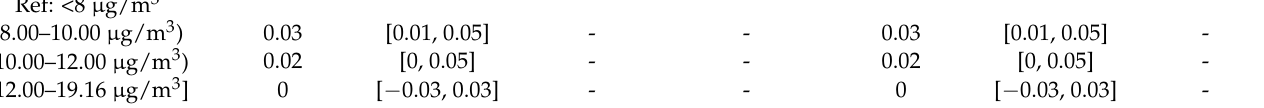
Panel B: Direct and indirect associations of the postnatal PM 2.5